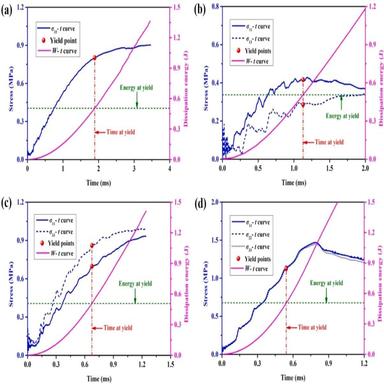
Determination of initial yield point for the KV lattice structure under multiaxial loadings: (a) uniaxial compression along 3-direction; (b) compression-shear at the strain loading ratio of 1:3; (c) biaxial compression at the strain loading ratio of 1:2; and (d) triaxial compression at the strain loading ratio of 1:1:1.